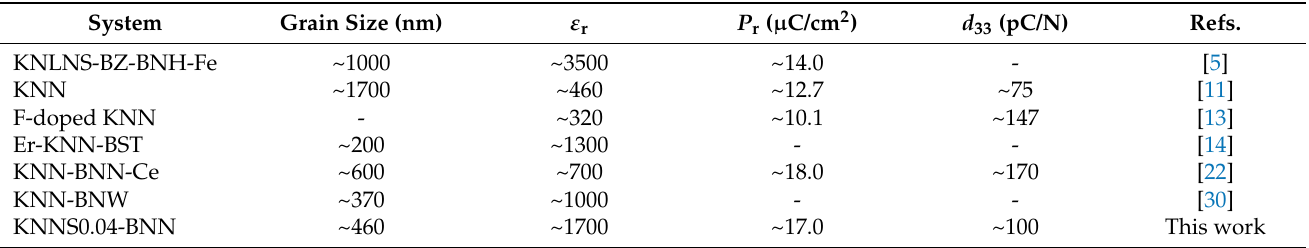
Table 1. Comparison of grain size, ε r , P r and piezoelectric coefficient d 33 between this system and other fine-grain KNN-based ceramics prepared by the traditional solid-state